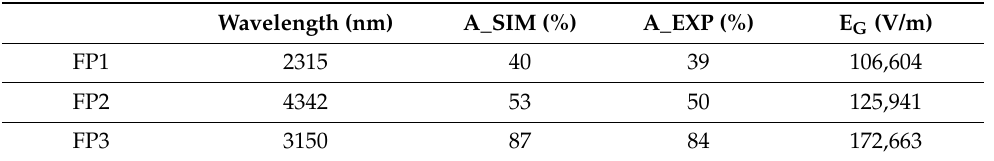
Figure 3. ( a ) Simulated transmittance (T), reflectance (R), and absorption (A) of Fabry–Perot filters FP1, FP2, and FP3; ( b ) electric field distribution inside the Fabry–Perot filters. SLG position is indicated in the three filters by a black line positioned at electric field maximum (red color). Table 2. Graphene-based Fabry–Perot characteristics. Simulated and experimental absorption and electric field value at SLG position (maximum of electric field).